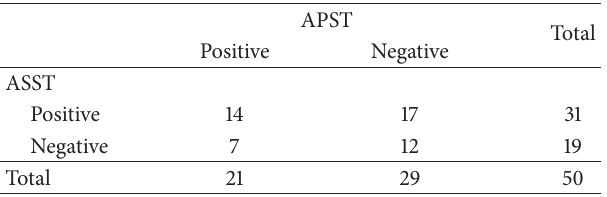
Table 2: The distribution of ASST and APST results of the patient group.